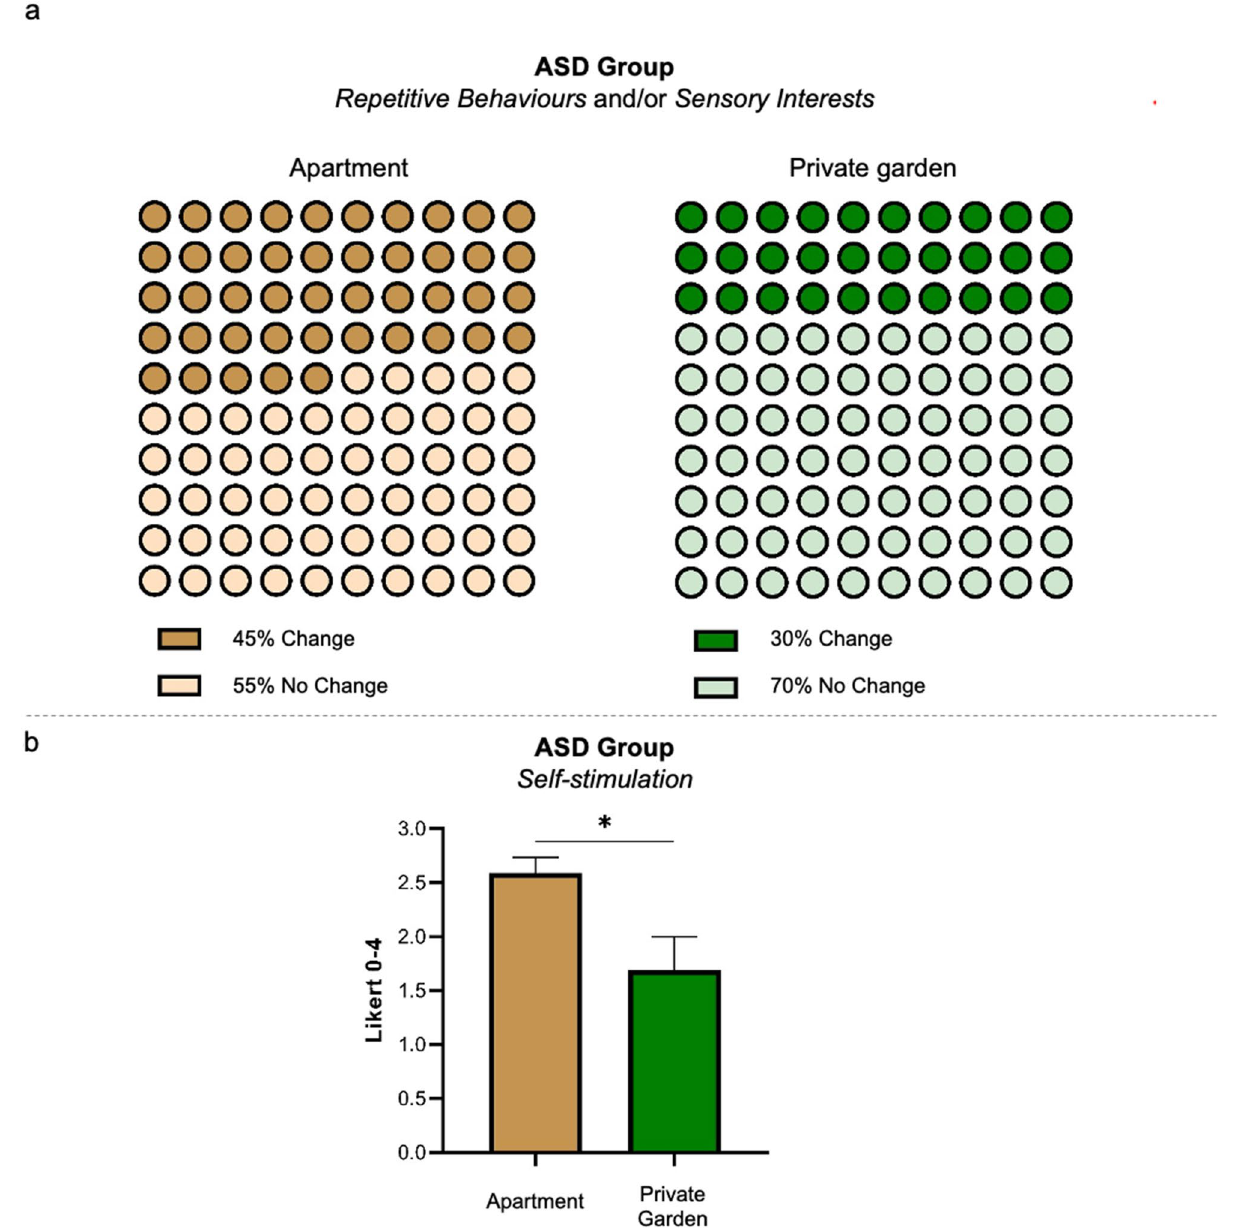
Figure 3. ( a ) Graphs illustrating the effects of House-Characteristics (apartment Vs. private garden) on Repetitive Behaviours and/or Sensory Interests domains within the ASD group (p = 0.036). ( b ) Graphs illustrating the effects of House-Characteristics (apartment Vs. private garden) on the self-stimulation sub-domain within the ASD group (p = 0.029). *Statistical significance, p < 0.05. Bars represent standard errors of the mean